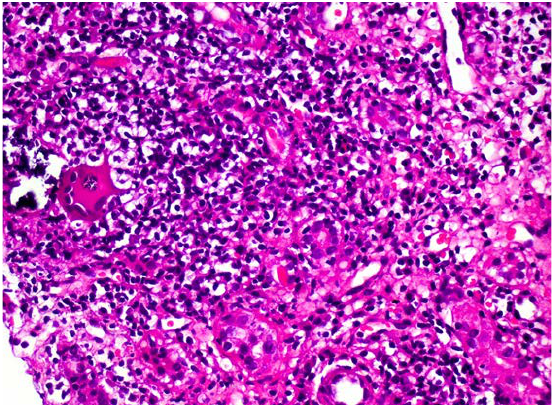
fIguRE 2 – Dense lymphomononuclear infiltrate in interstitium. There is a predominance of small cells, but larger cells with a histiocytic phenotype can also be observed, as well as sparse multinucleated cells. No cells with Reed-Sternberg phenotype, necrosis and granulomas were observed. HE, 200X.